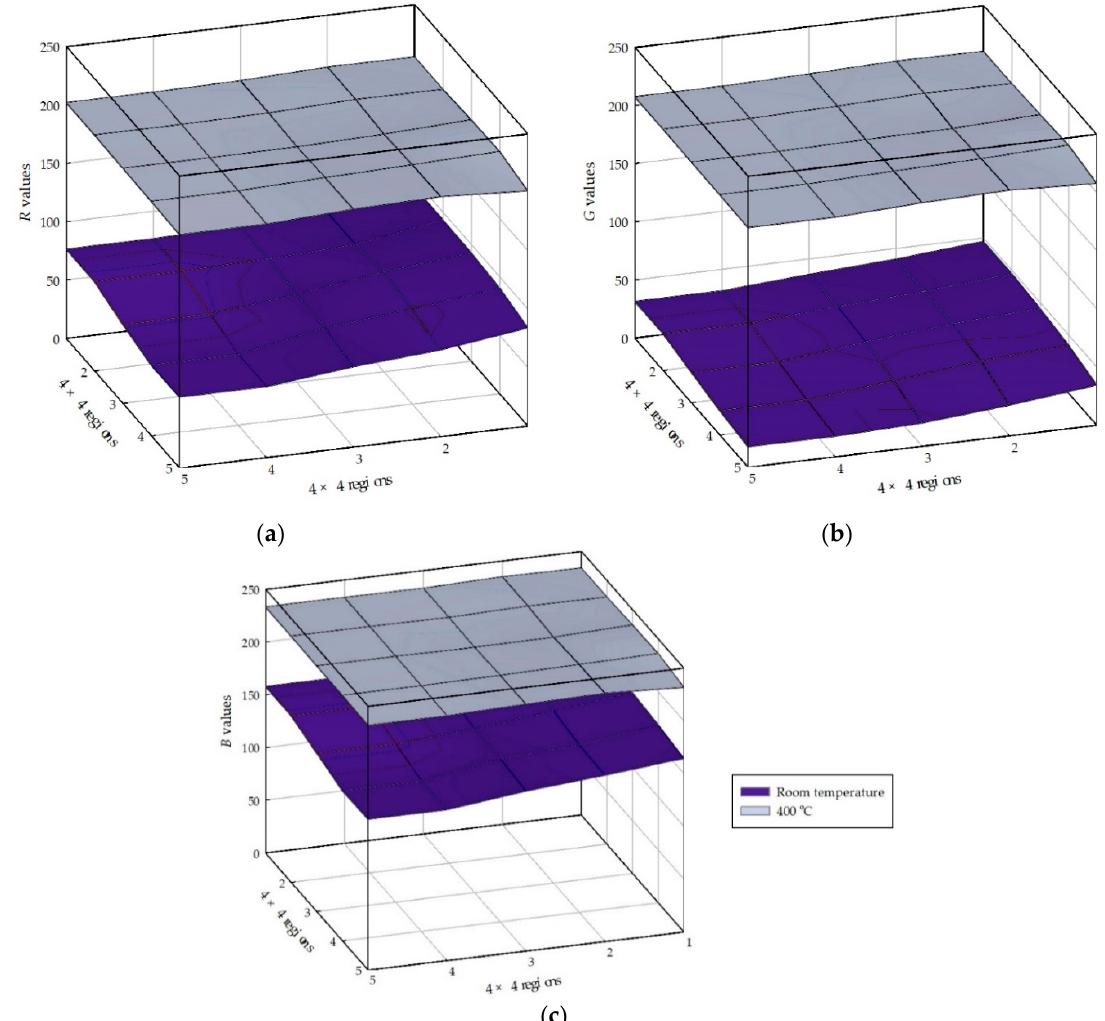
Figure 9. Color intensities in 4 × 4 regions on the surface: ( a ) R values; ( b ) G values; ( c ) B values.